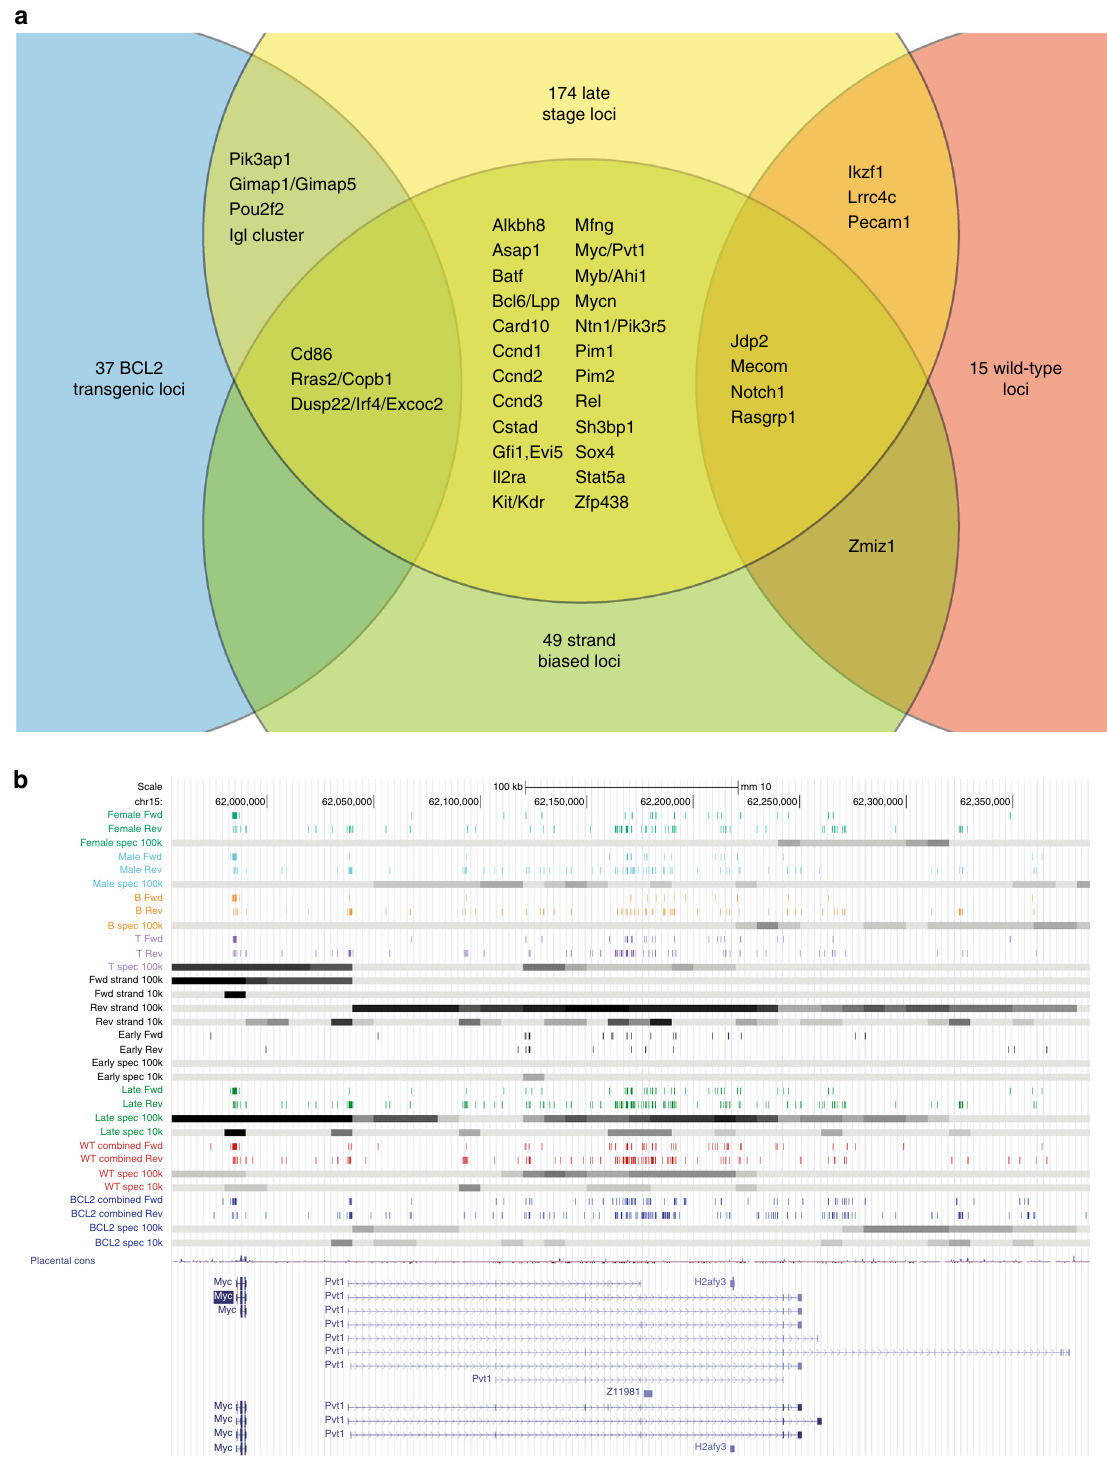
Fig. 5 Genome-wide scanning of subclonal mutation distributions identi fi es regions undergoing selection. a Genome-wide contingency table tests of all mutations identi fi es loci that are late-stage speci fi c, strand biased and genotype biased. The Venn diagram demonstrates substantial overlap between loci identi fi ed by these criteria. b Distribution of integrations over the Myc/Pvt1 locus. Each row of colored vertical lines represents the forward and reverse strand integrations of each category of mice. Gray bands below each colored row represent the level of selection evidenced by contingency table tests. Late-stage speci fi c integrations are evident throughout the region; however, integrations upstream of Myc are primarily on the forward strand and T cell speci fi c whereas integrations within the Pvt1 gene are in the reverse orientation and somewhat biased toward wild-type